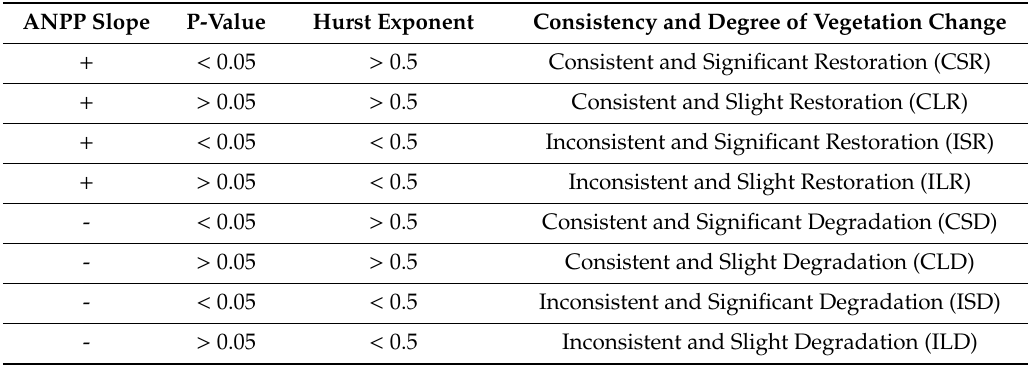
Figure8. ThematerialusedtocalculatethedegreeofANPPchangeanditssustainability: ( a , b )theslopes of base and restoration periods; ( c , d ) the P-values of ANPP for base and restoration periods; ( e , f ) calculated Hurst values for base and restoration periods. Table 3. Scenarios for the degree of ANPP change and its